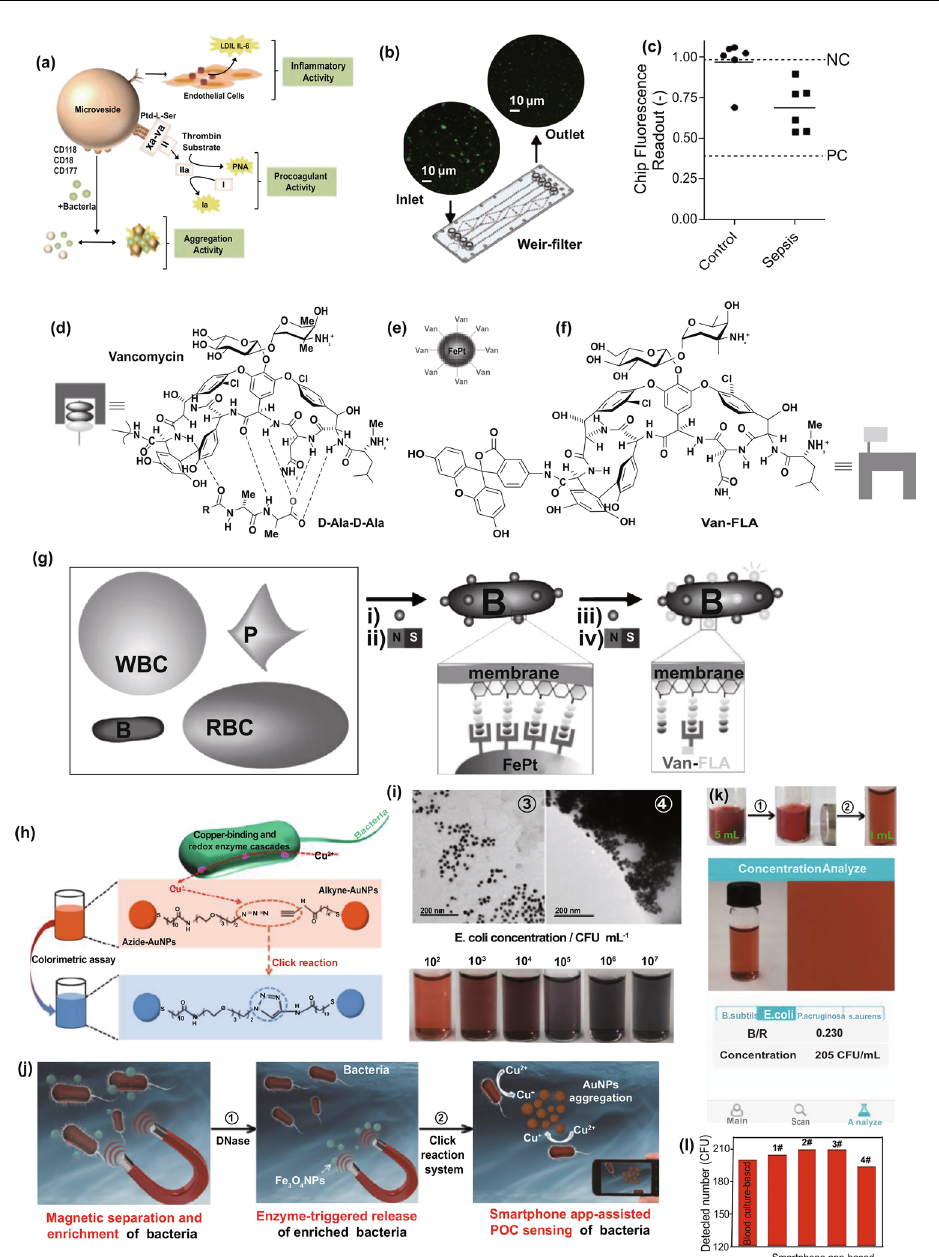
Fig. 3 Innate immune cell-derived microvesicles differentiate sepsis from noninfectious systemic inflammation. a PMN-derived microvesicles induced bacterial aggregation, procoagulant activity and inflammatory response in endothelial cells. b PMN-derived microvesicle-based point-of-care-compatible microfluidic chip with four separation channels. c Detection of 12 clinical samples from control ( n = 6) and sepsis ( n = 6) patients using a microvesicle-based microfluidic chip. NC, negative control; PC, positive control. Reproduced with permission from Ref. [135]. Copyright 2015 Royal Society of Chemistry. Design and mechanism of the FePt@Van nanoparticle-Van fluorescent probe detection system for the rapid detection of bacteria in human blood. d Multivalent binding of Van to bacterial sur- face terminal peptide D-Ala-D-Ala. e Schematic drawing of FePt@Van nanoparticles. f Chemical structure of Van fluorescent probe (Van-FLA). g Illustration of bacterial detection step. Bacteria were captured by FePt@Van nanoparticles with magnetic assistance, and the resultant bacteria were stained by Van-FLA and mag- netically separated from the blood separation. Reproduced with permission from Ref. [139]. Copyright 2006 John Wiley and Sons, Inc. Bacteria-instructed click chemistry-guided functionalized AuNPs for point-of-care microbial detection. h Conceptual mechanism of the colorimetric transformation of functional AuNPs triggered by bacteria-instructed click chemistry. i TEM images and colorimetric photographs indicating the bacteria-instructed click reaction between the azide- and alkyne-AuNPs, resulting in AuNP aggregation (TEM images) and color transformation (colorimetric photographs). j Schematic illustration of bacteria-instructed click chemistry-guided AuNPs sensor combining magnetic separation and smartphone app-assisted colorimetric strategy. k Experimental photographs for the click chemistry-guided AuNP sensing of E. coli from complex artificial sepsis blood samples. The concentration of E. coli could be analyzed by smartphone colorimetric strategy. l Detected E. coli numbers of four parallel artificial sepsis blood samples by the click chemistry-guided AuNP platform. Reproduced with permission